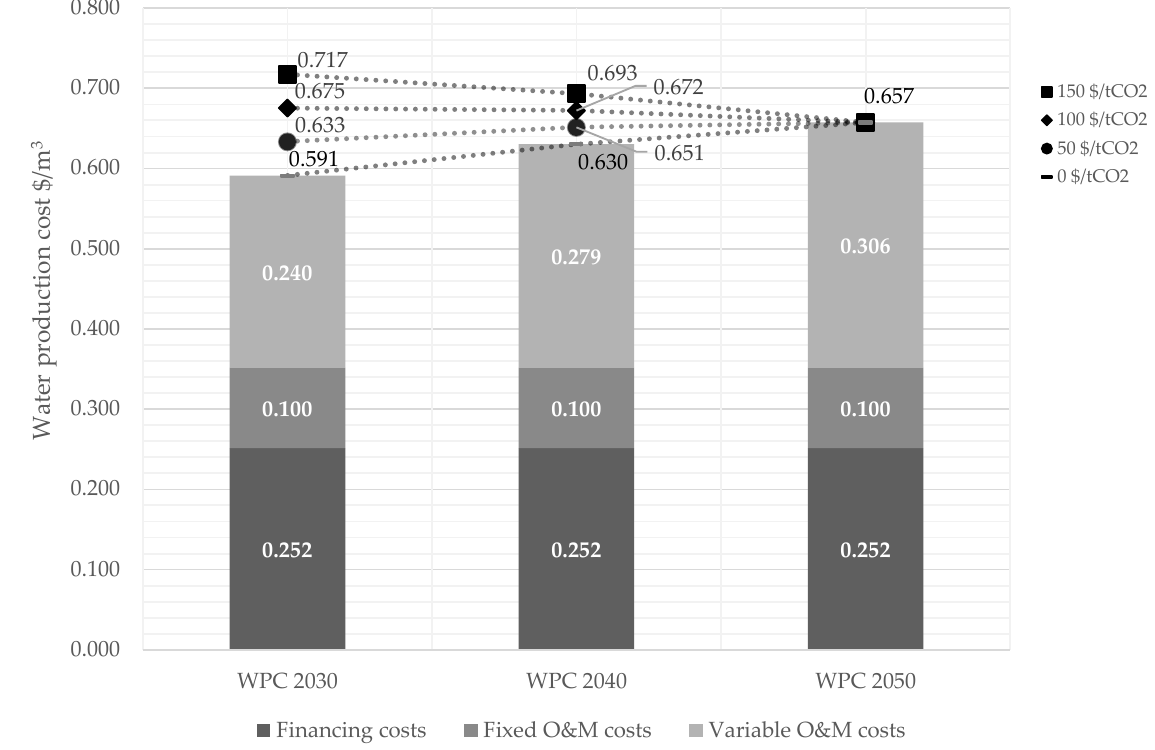
Figure 7. Comparison of water production cost varying the carbon tax level for Alternative No. 3.